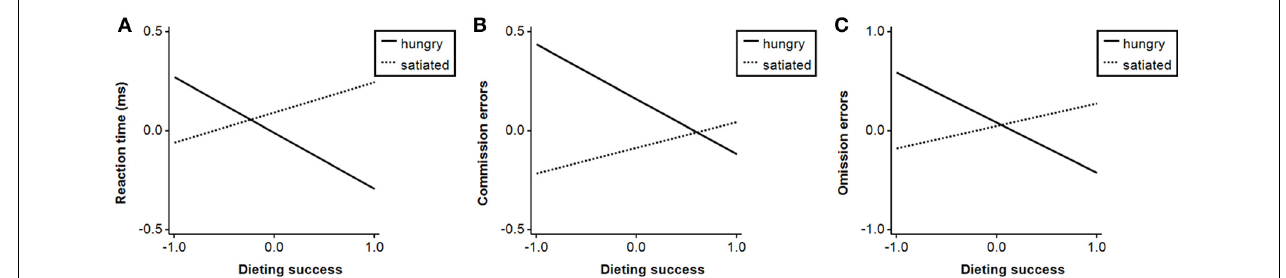
FIGURE 7 | Task performance in blocks with food targets as a function of group and dieting success in study 2: (A) reaction time in go-trials in ms, (B) number of commission, and (C) omission errors. All variables are z